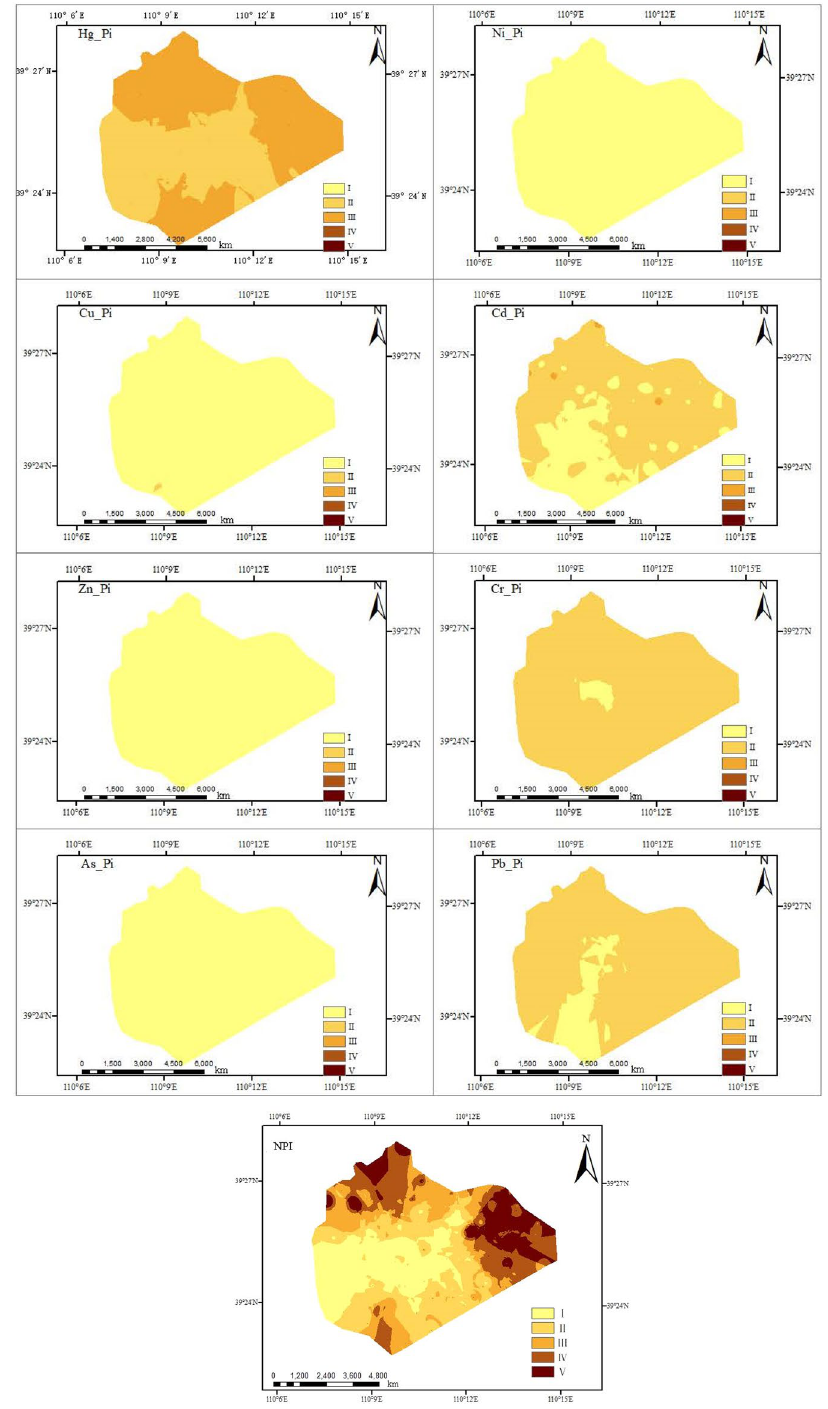
Figure 2. Spatial distribution of P i and NPI of heavy metal in the study area (created by Arcgis 10.8, http:// deskt op. arcgis. com/